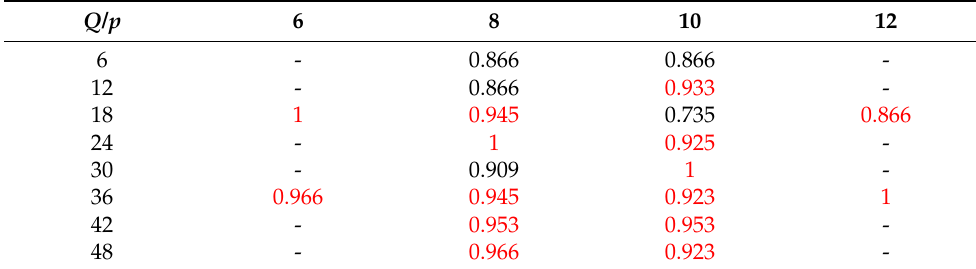
Table 2. The winding factor of varied slot/pole